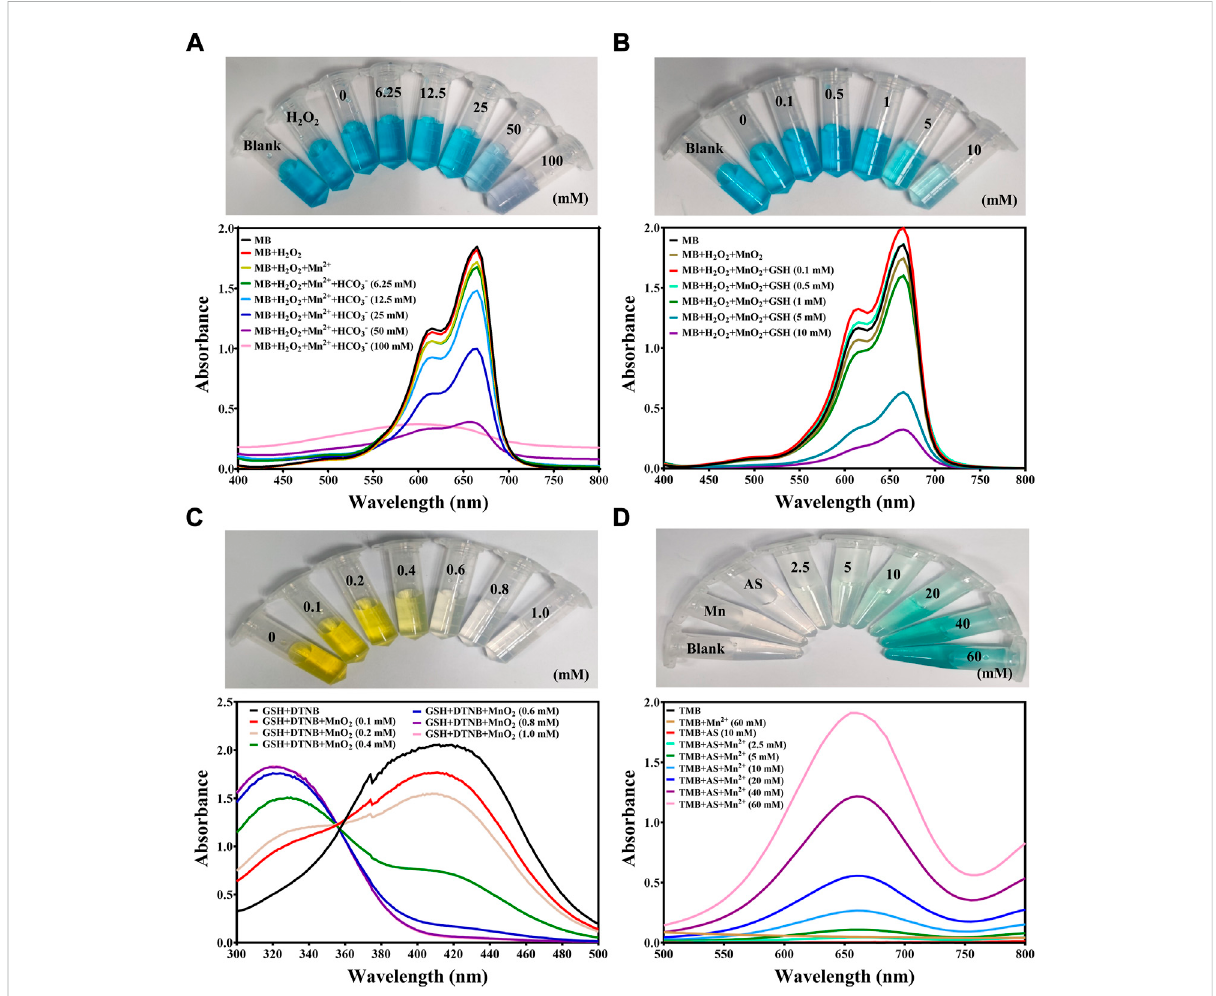
FIGURE 1 InvestigationofROSgenerationfrommanganese-basedmaterials. (A) UV-Vis-NIRspectrumofMB(10 μ g/ml)beforeandafterbeingincubated in H 2 O 2 (1 mM), Mn 2+ (0.5 mM) and HCO 3 − (6.25, 12.5, 25, 50or 100 mM) atroom temperature for 30 min. The inserted photo represented the color change of MB before and after being incubated in different solutions at room temperature for 30 min (B) UV-Vis-NIR spectrum of MB (10 μ g/ml) beforeandafterbeingincubatedinH 2 O 2 (1 mM),MnO 2 (0.5 mMequivalenttoMn 2+ )andGSH(0.1,0.5,1,5,and10 mM)atroomtemperaturefor 30 min. The inserted photo represented the color change of MB before and after being incubated in different solutions at room temperature for 30 min (C) UV-Vis-NIR spectrum exhibiting the GSH depletion of solutions when incubated with GSH (0.5 mM), DTNB (0.1 mM) and MnO 2 (0.1, 0.2, 0.4, 0.6, 0.8 and 1.0 mM) at room temperature. The inserted photo represented the color change of GSH depletion process. (D) UV-Vis-NIR spectrum of TMB (1 mg/ml) before and after being incubated with AS (10 mM) and Mn 2+ (2.5, 5, 10, 20, 40, and 60 mM) at room temperature for 30 min. The inserted photo represented the color change of TMB before and after being incubated in different solutions at room temperature for 30